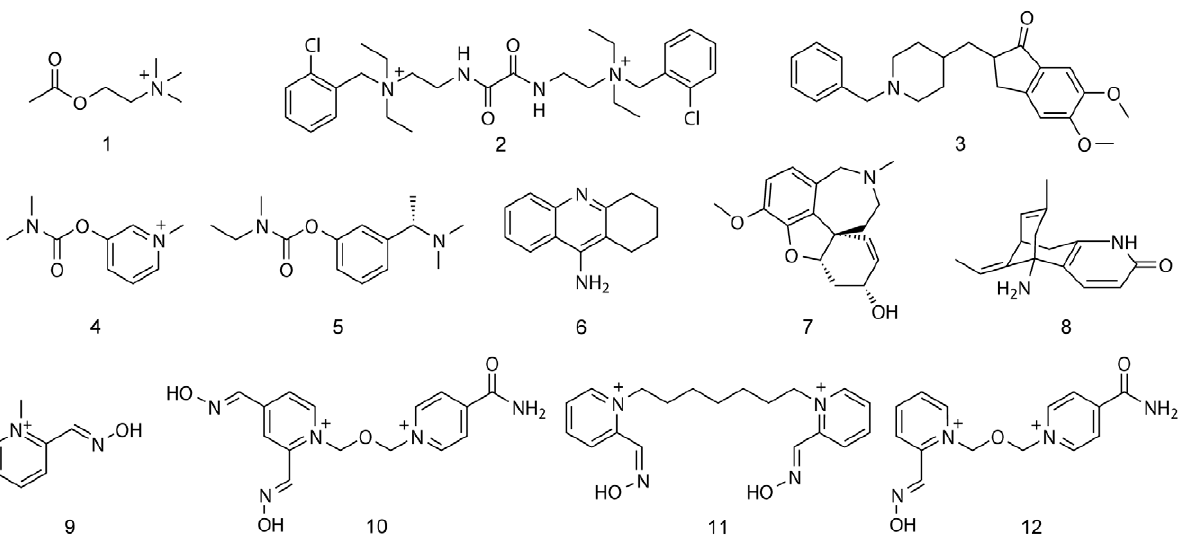
Figure 1. Chemical structures of ligands that bind to AChE. The native substrate acetylcholine 1 ; inhibitors, ambenonium 2 , donepezil 3 , pyridostigmine 4 , rivastigmine 5 , tacrine 6 , galanthamine 7 and huperzine A 8 ; nerve agent antidotes, 2-PAM 9 , HLo¨-7 10 , ortho-7 11 and HI-6 12 .